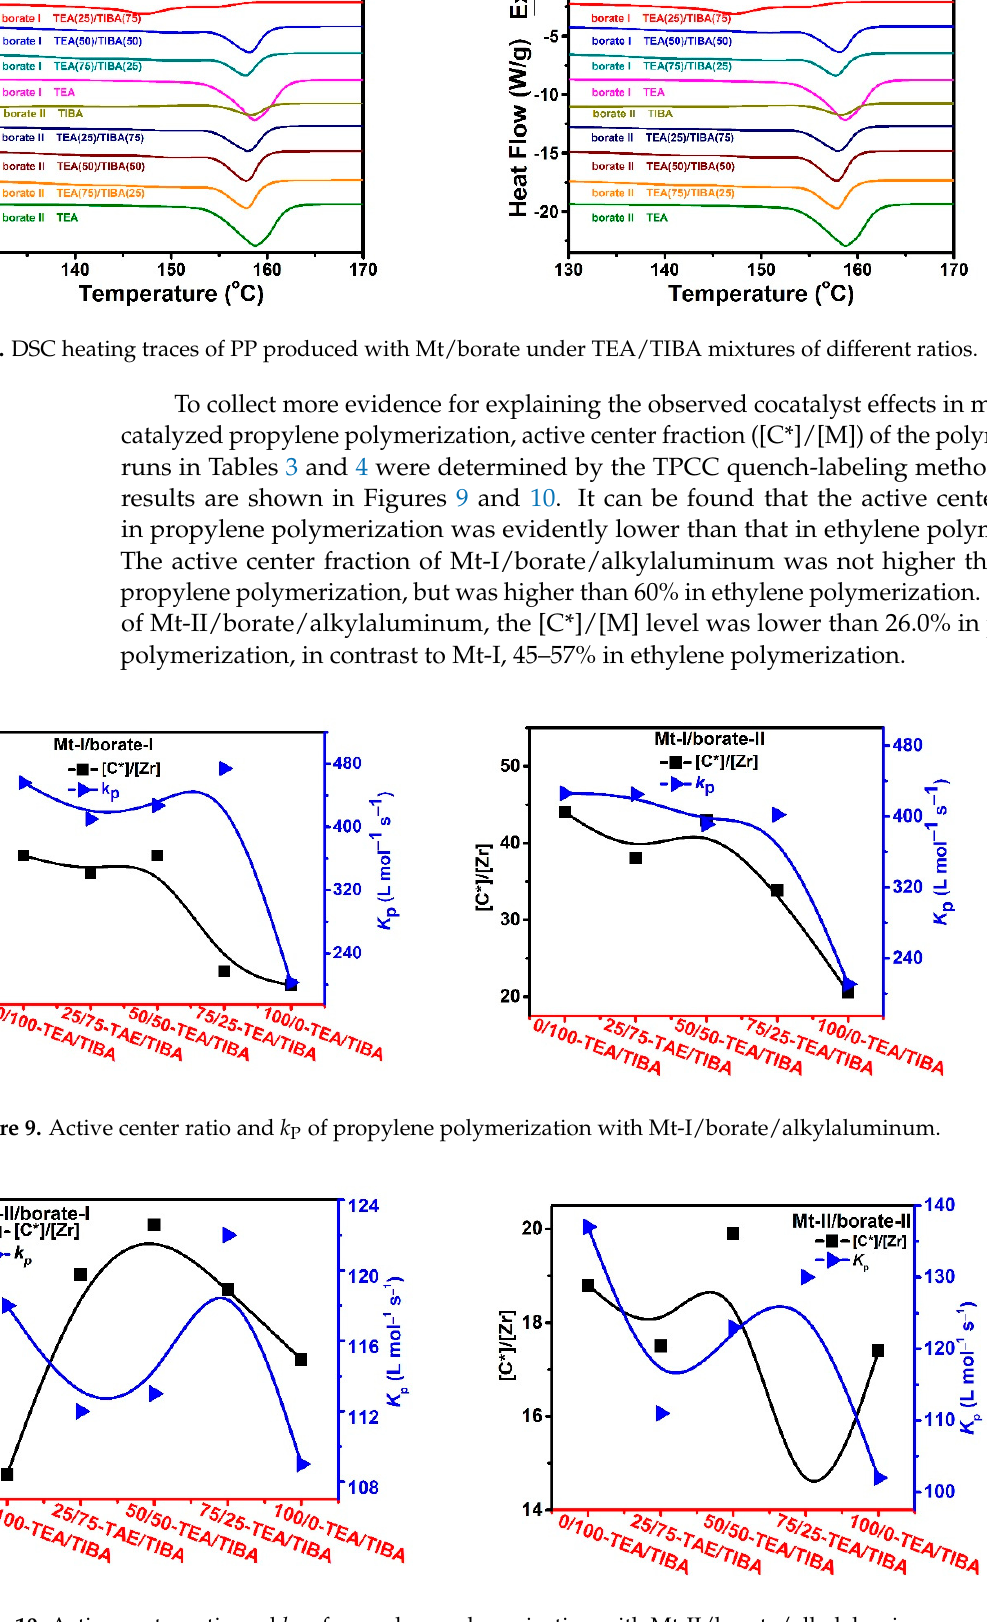
Figure 10. Active center ratio and k P of propylene polymerization with Mt-II/borate/alkylaluminum.